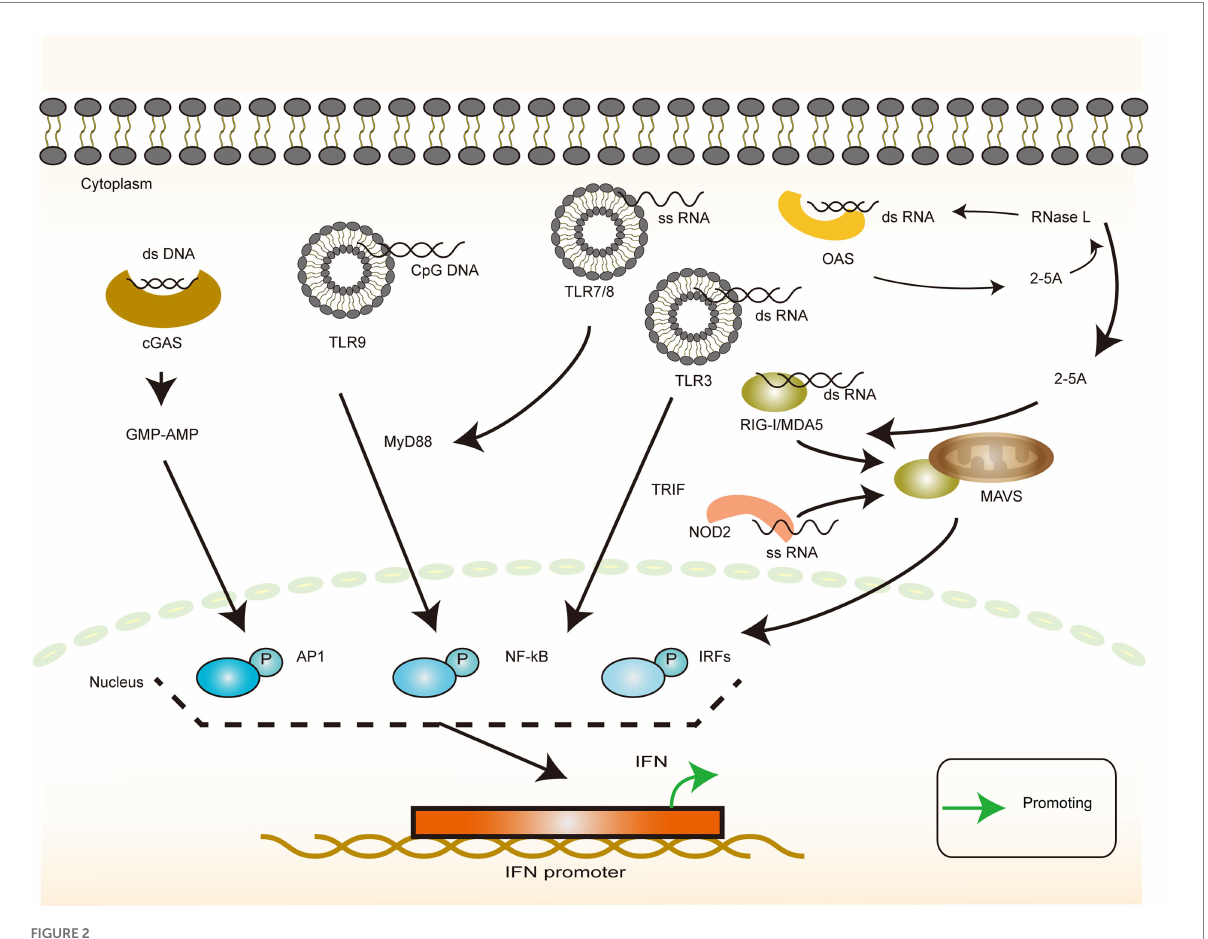
FIGURE 2 Interferon production in response to heterologous nucleic acid invasion. The illustration of the recognition of different types of viral nucleic acids by host cells and their downstream responses. dsDNA-dependent cGAS induces IFN production via the GMP-AMP pathway. cpGDNA-dependent TLR9 induces IFN production via the MyD88 pathway. dsRNA induces IFN production via the TLR3/TRIF pathway or the RIG-I family/MAVS pathway, or it can be recognized by OAS, producing 2-5A, thereby activating RNA enzymes or activating the intracytoplasmic RNA sensors. ssRNA induces IFN production via the TLR7(TLR8)/MyD88 pathways or NOD2/MAVS